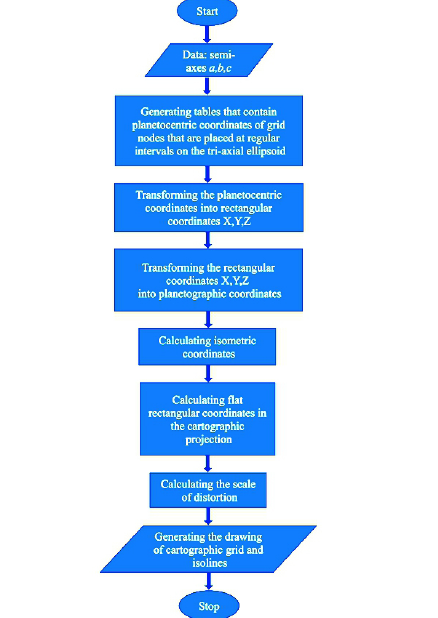
Fig. 1. Diagram of the stages of calculating and visualising cartographic grids and distortions